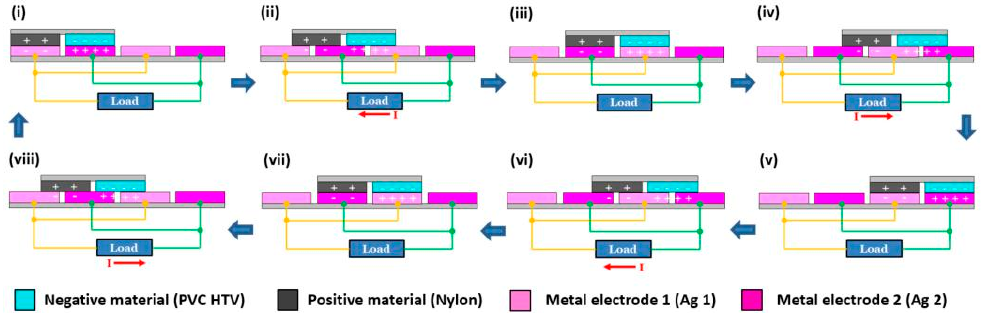
Figure 2. Schematic illustration of the operating mechanism of pnG-TENG for N = 2.